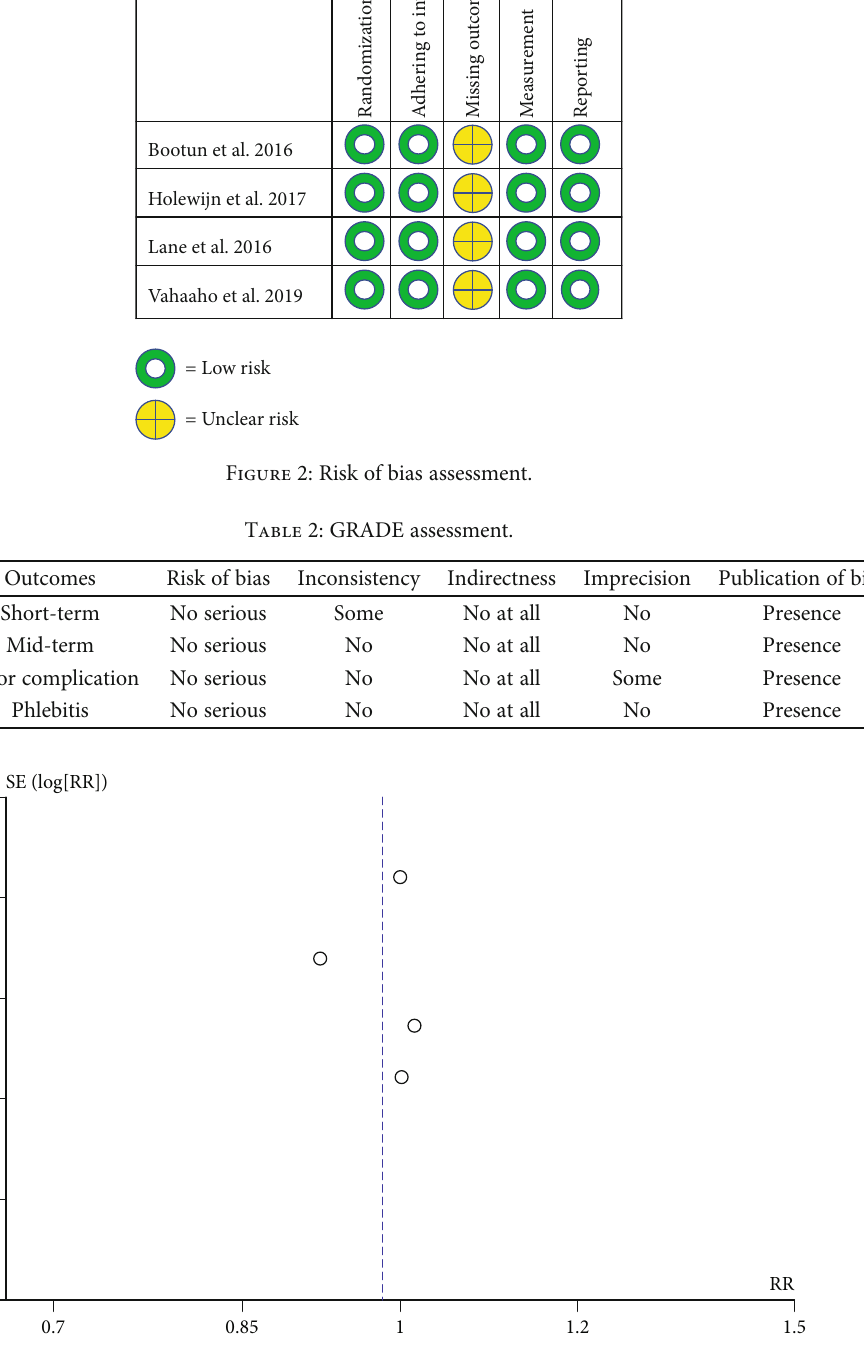
Figure 3: Funnel plot of comparisons: mechanochemical ablation vs thermal ablation intention-to-treat analysis, outcome: anatomical success